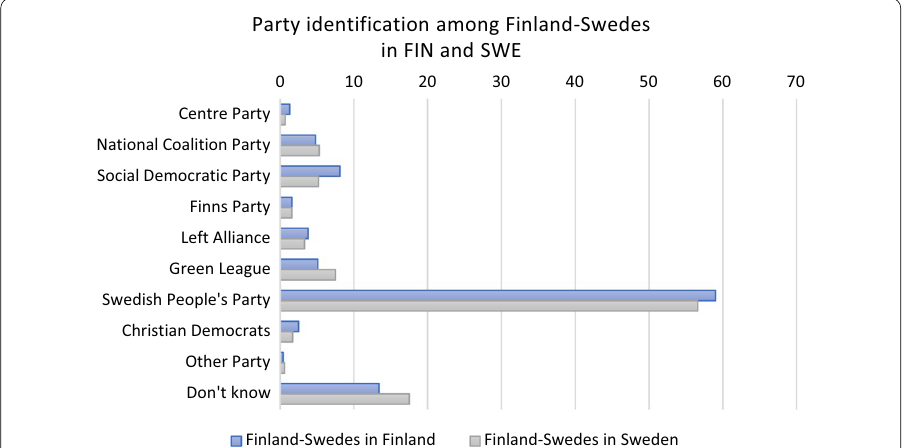
Fig. 1 Share (%) of Finland-Swedes in Finland and in Sweden identifying with different parties in